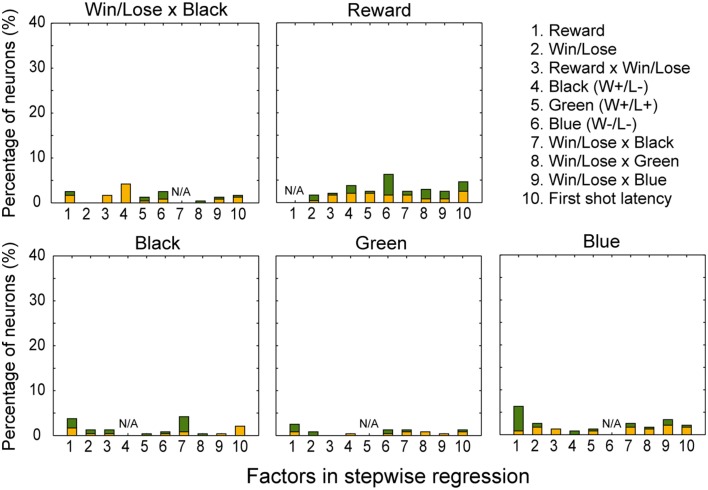
Percentage of neurons coding each factor concurrently with Win/Lose x Black, Black, Green, Blue, and Reward factors, respectively, in the stepwise regression. For example, about 4% of neurons were selected for both Reward and Black factors (1 in the panel for Black). Conventions are the same as in Figure 6.